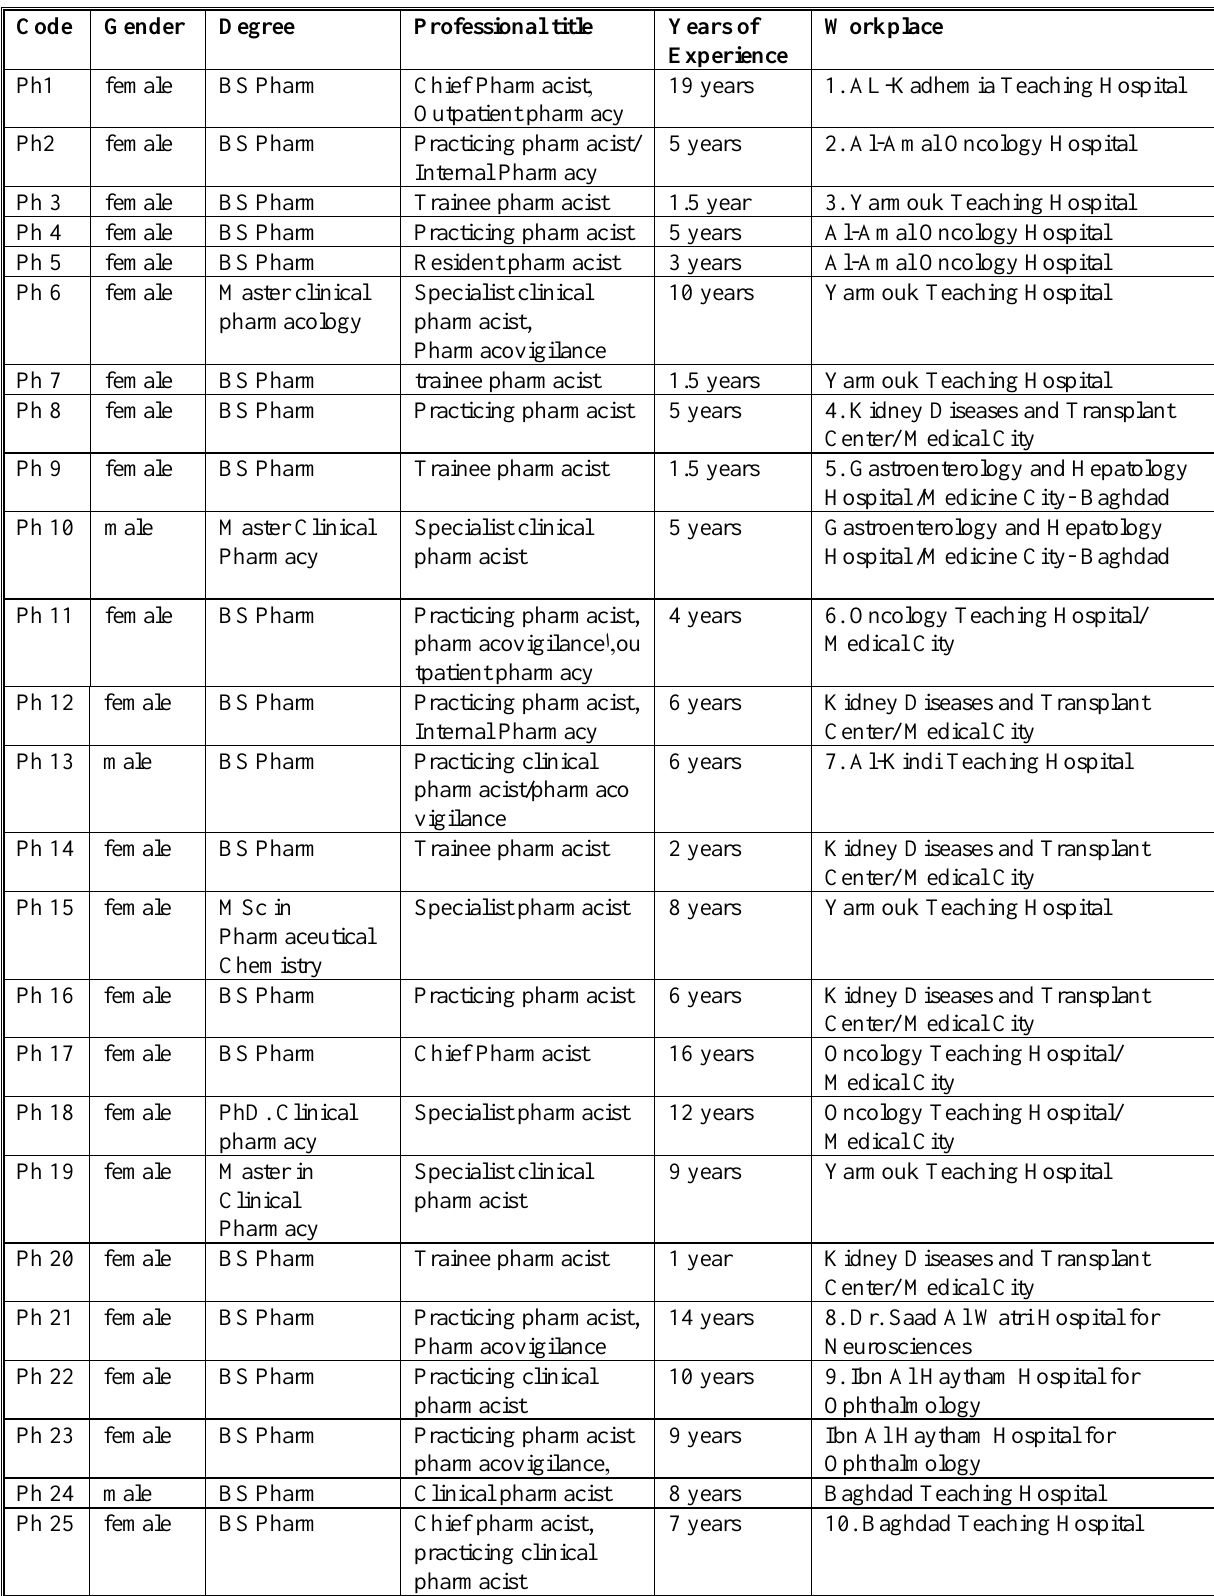
Table 1. Demographics characteristic of